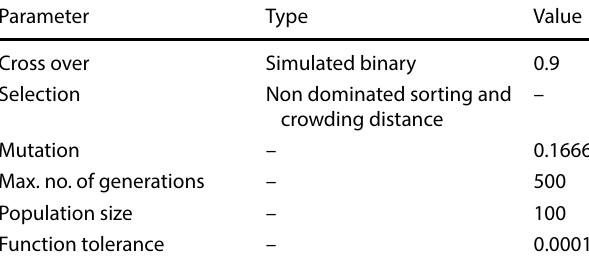
Table 11 RSME for AF and St